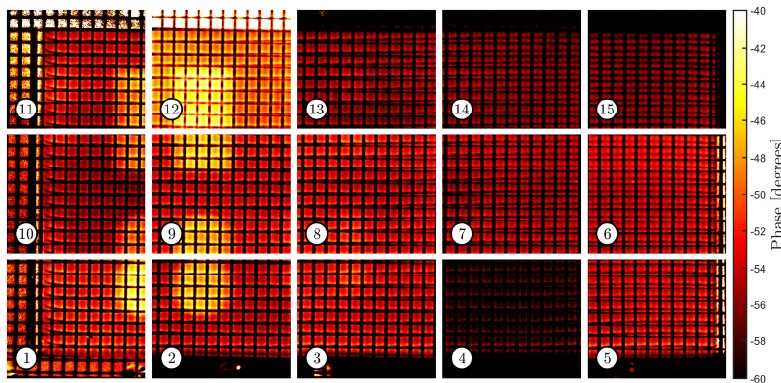
Figure 10. Set of phasegrams taken from the sample without the superposed grid. Figure 11 highlights the initial estimate of the overlaps in each set of images. The images were encoded with the camera shooting positions and scaled by the measured resolution value. The known pitch of the grid (3 mm) was used to estimate the resolution of the images, which was 150 μ m/pixel ( ≅ 4444 pixels/cm 2 ). Figure 11a,b relate to the set of images with and without the grid, respectively. There, the image pixels were plotted with 50% transparency to allow visualising the overlaps, which are more clearly illustrated in